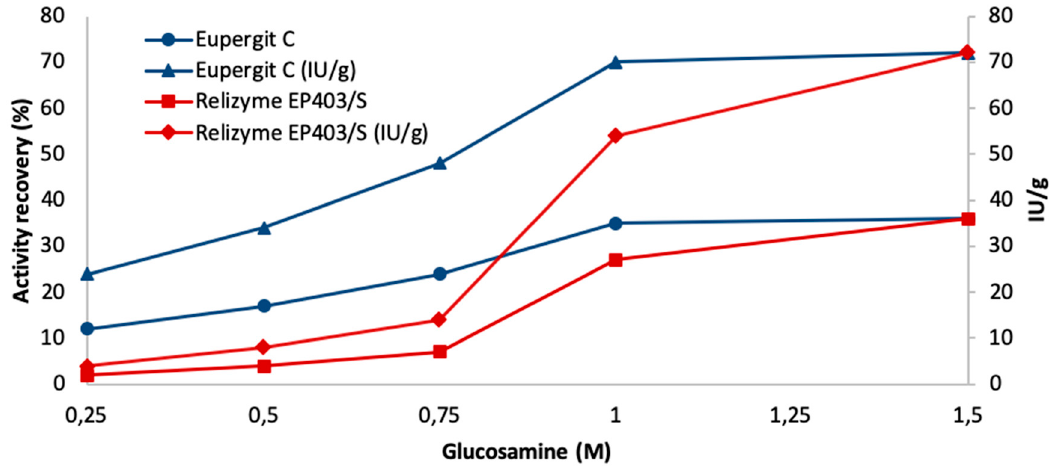
Figure 1. Immobilization of PGA on Eupergit C and Relizyme EP403 / S activated with glucosamine at di ff erent concentrations.